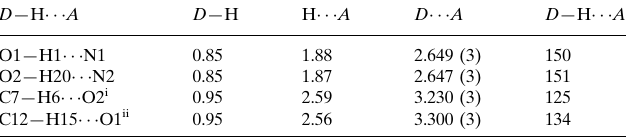
Hydrogen-bond geometry (A˚ , (cid:4)